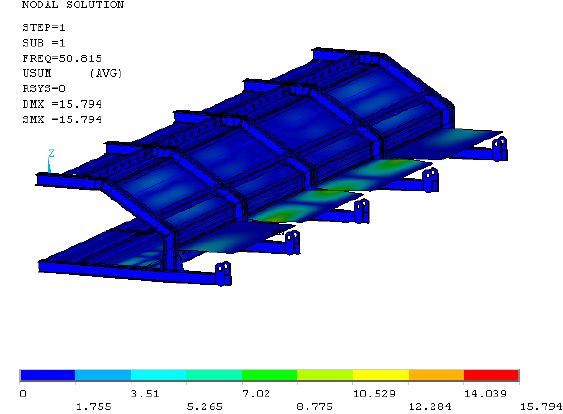
Figure 16: Elastic mode shape for the first natural frequency. Figure 17: Elastic mode shape for the second natural